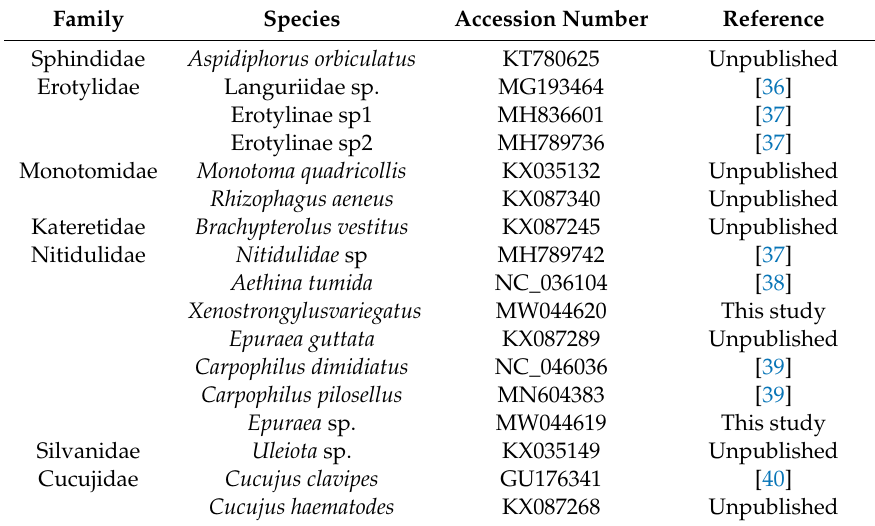
Table 1. Summary of the mitogenomic sequence information used in the present